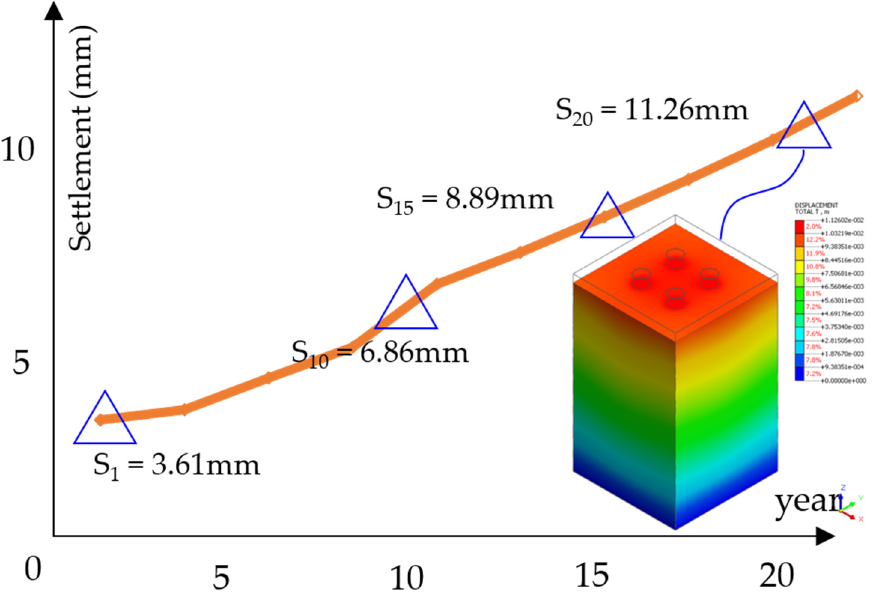
Figure 10. Long-term settlement predicted by FEM analysis.